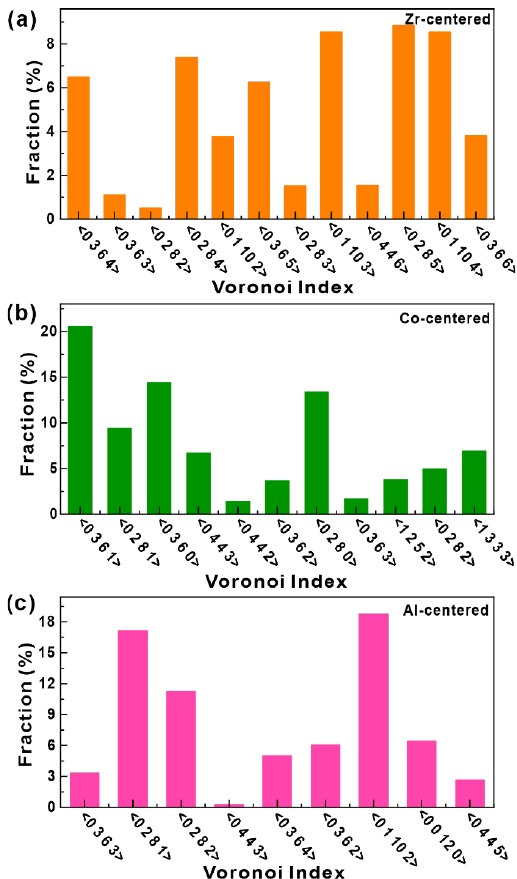
Figure 7. Distributions of Voronoi polyhedron centered by the ( a ) Zr, ( b ) Co, and ( c ) Al atoms, re- spectively.